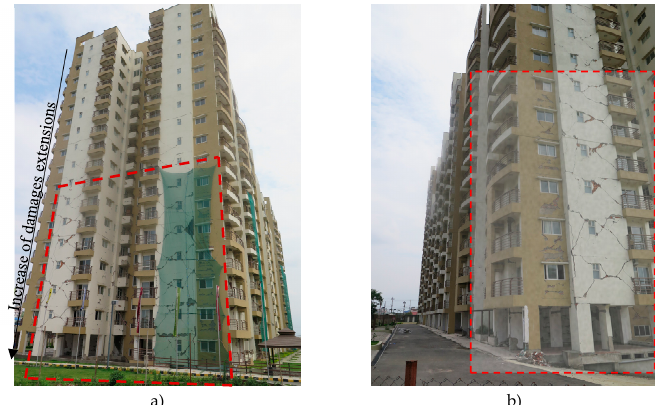
Figure 5. Survey damage assessment of the building: ( a ) north façade; ( b ) south-east façade.